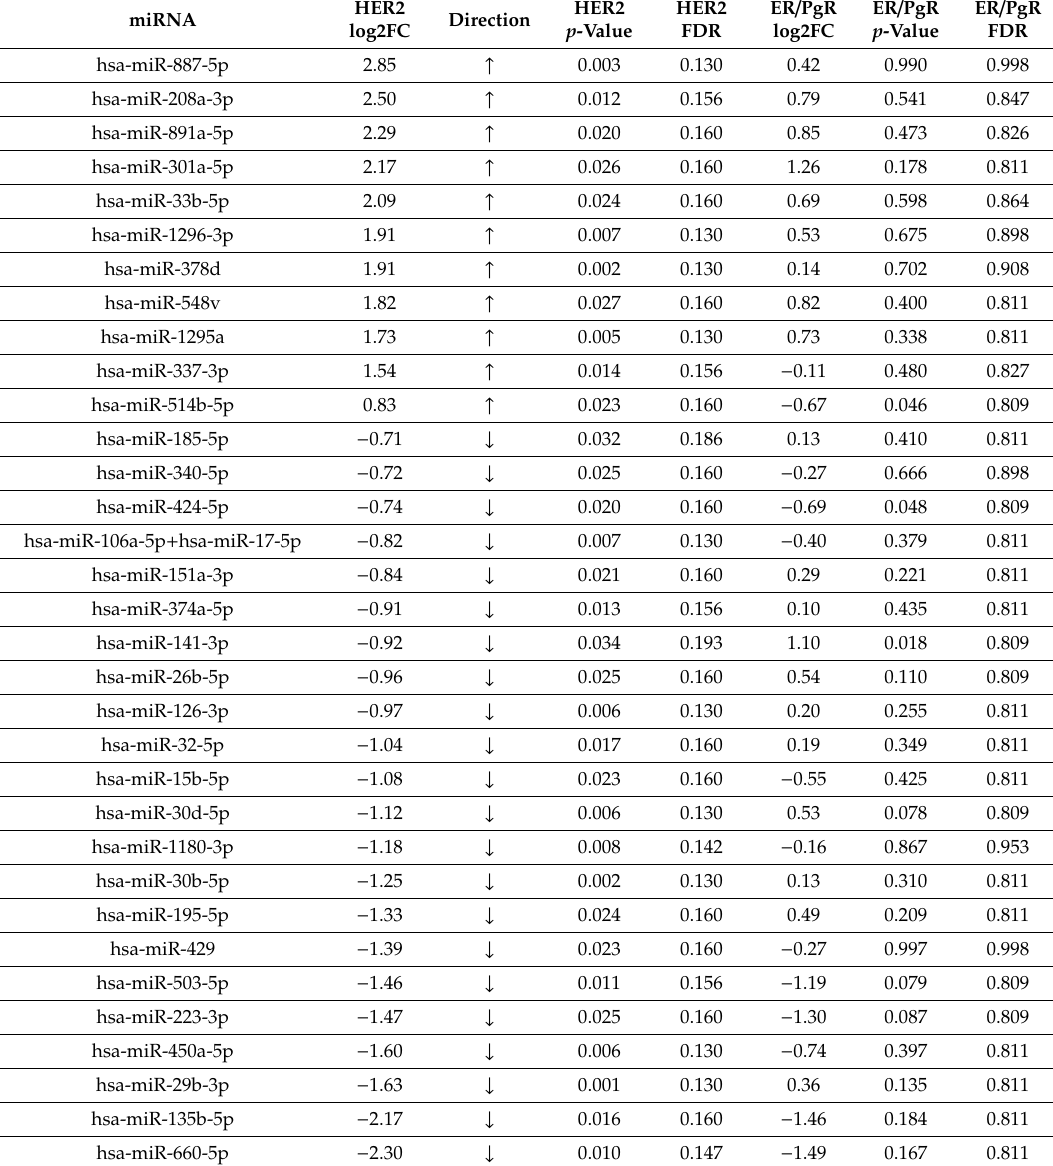
Table 3. HER2-associated miRNAs in single hormone receptor-positive breast tumors; log2fold change (log2FC) calculated for the mean normalized counts of each probe in compared groups—HER2( + ) vs. HER2( − ); miRNAs upregulated in HER2( + ) tumors are marked with ↑ , miRNAs downregulated in HER2( + ) tumors are marked with ↓ ; di ff erences estimated with Two-Way ANOVA ( p -value) with Benjamini–Hochberg correction (FDR), only statistically significant results (FDR ≤ 0.2) are presented; miRNA names are according to miRBase database